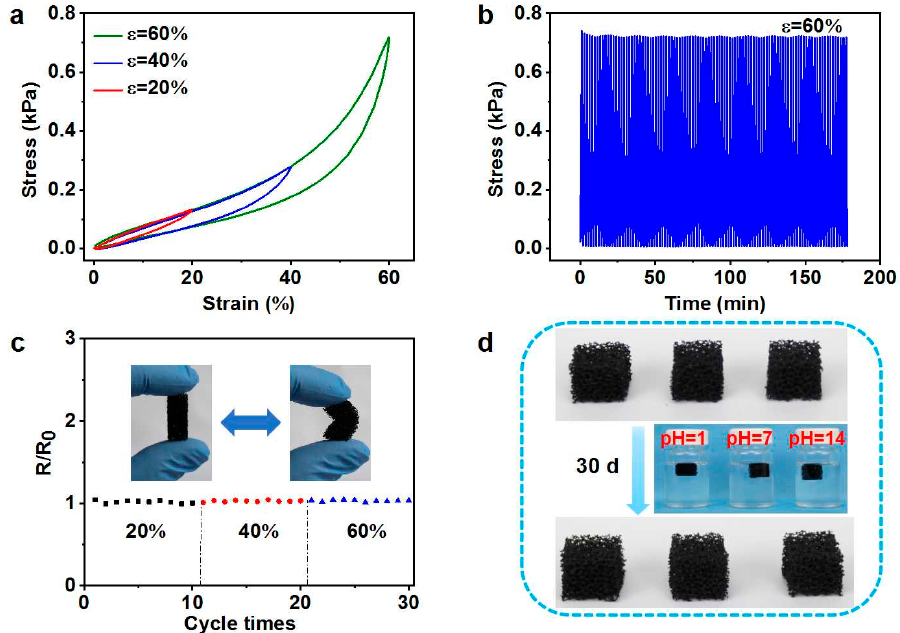
Figure 3. ( a ) Stress–strain curves of CPS at maximum strains of 20%, 40%, and 60%. ( b ) Cyclic compressive test of CPS at 60% strain for 100 cycles. ( c ) Electrical resistance change of CPS after cyclic bending to different degrees. ( d ) Structural stability of CPS after immersion into pH = 1, 7, and 14 solutions for 30